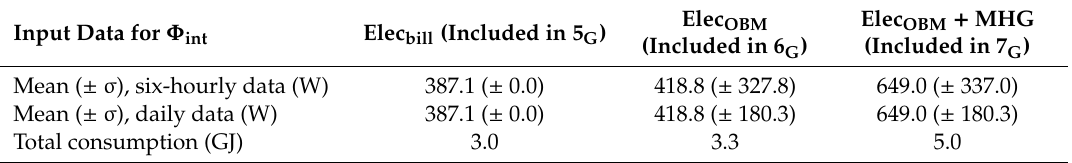
Table 7. Specification of the input data used to represent Φ int , for the training period.